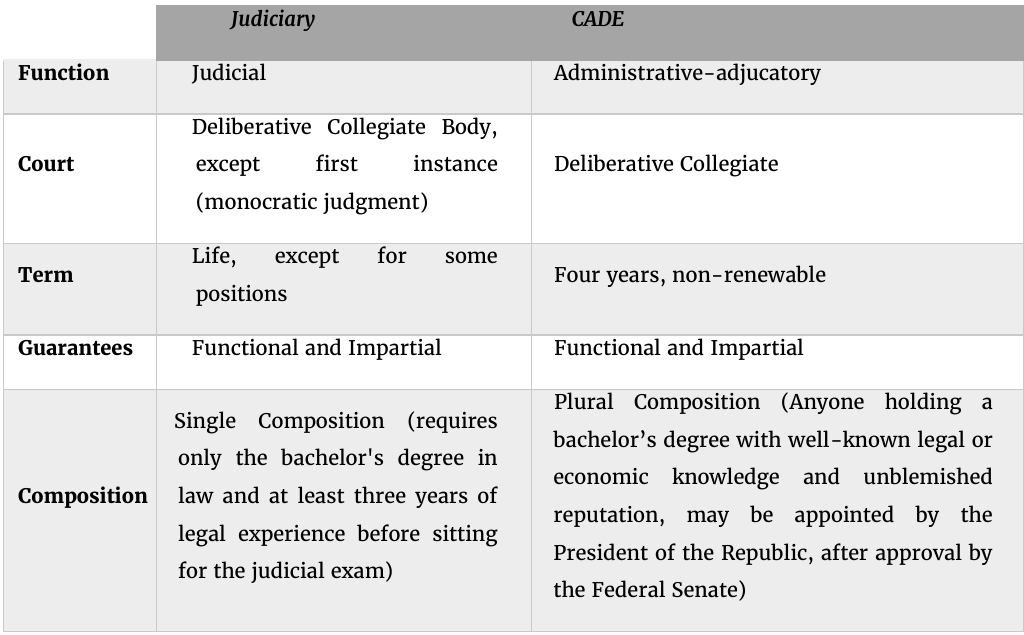
Table 1. Comparative approach of Brazilian Judiciary and